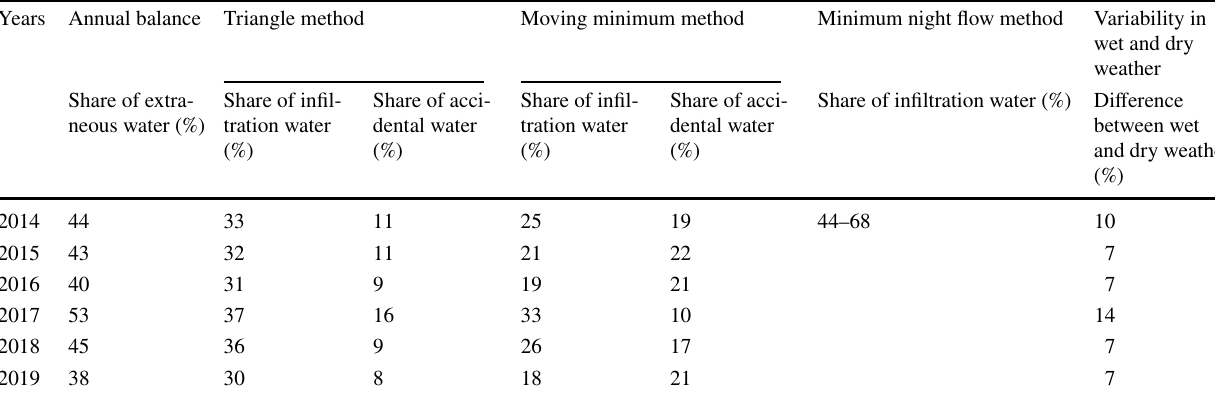
Table 5 Results obtained from every considered method Years Annual balance Triangle method Moving minimum method Minimum night flow